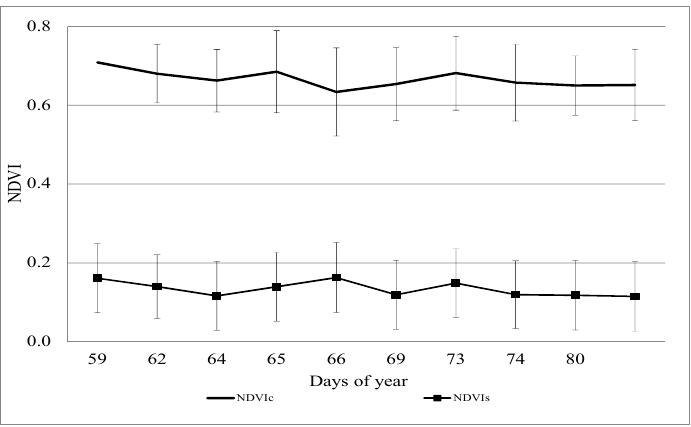
Figure 4. Mean values of the normalized difference vegetation index of (NDVI) of a drip-irrigated olive orchard using a multispectral camera placed aboard an unmanned aerial vehicle (UAV). Sub-indexes “c” and “s” denote values from the canopy and soil surface, respectively. Vertical lines indicate one standard deviation.